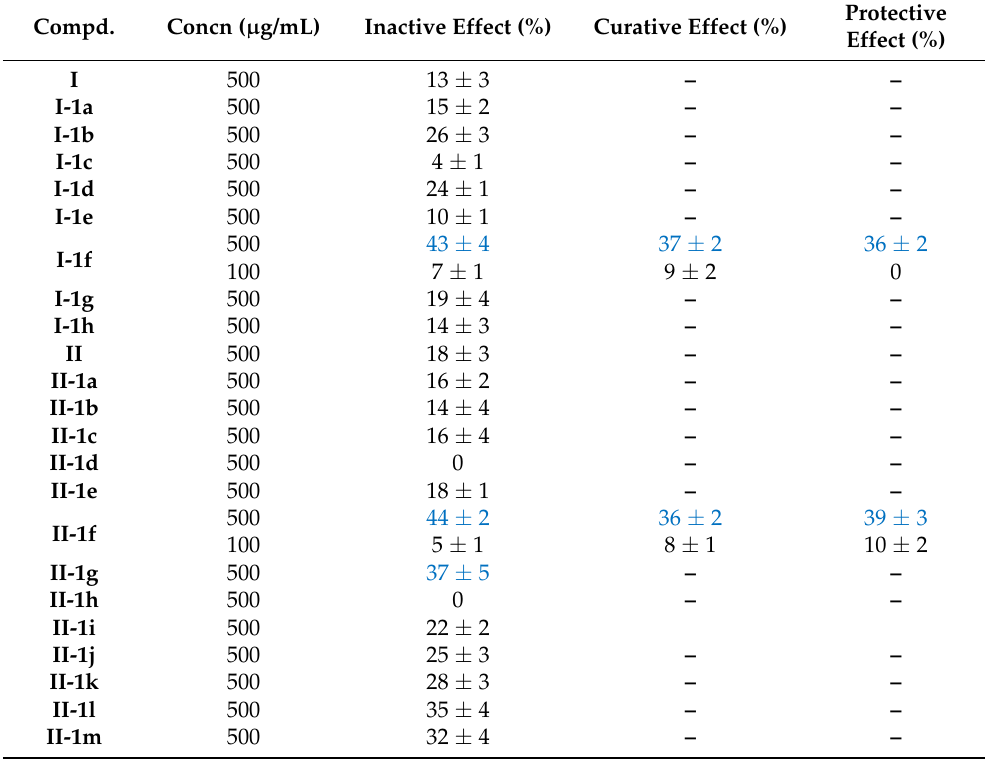
Table 3. In vivo antiviral activities of compounds I , II , III , I-1a – I-1h , II-1a – II-1m , III-1a – III-1f and ribavirin against TMV a